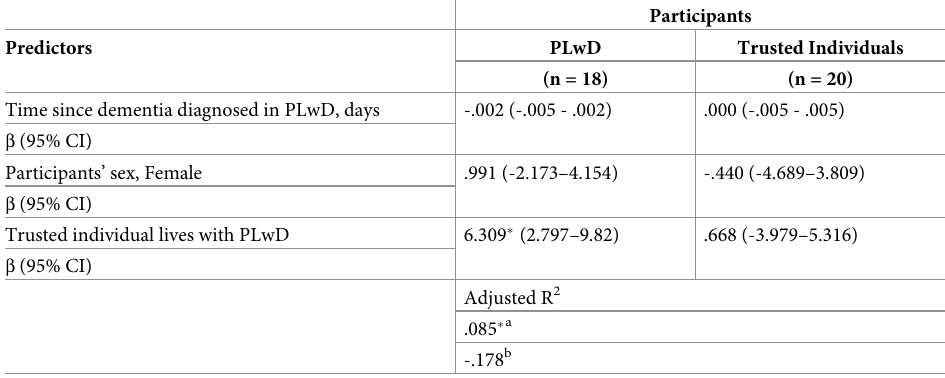
Table 3. Standard multiple regression results for TEI acceptability